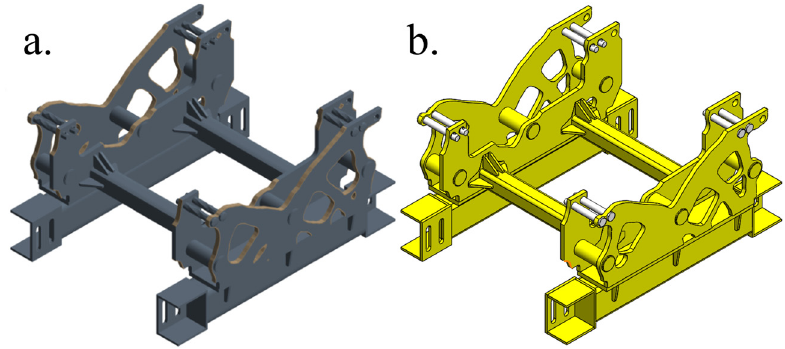
Figure 14: Topology optimized results from PS2 ( * = V 60%, equal weights ) : ( a ) density iso - line using ≥ ρ 0.6 in workbench and ( b ) CAD model created in SolidWorks.